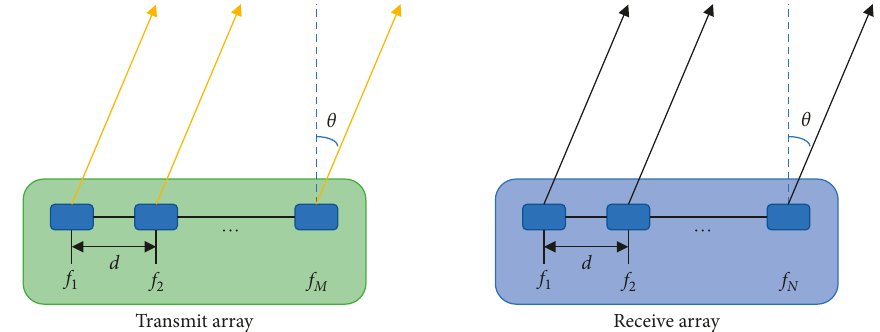
Figure 1: The model of the monostatic FDA-MIMO. (a) Transmit array. (b) Receive